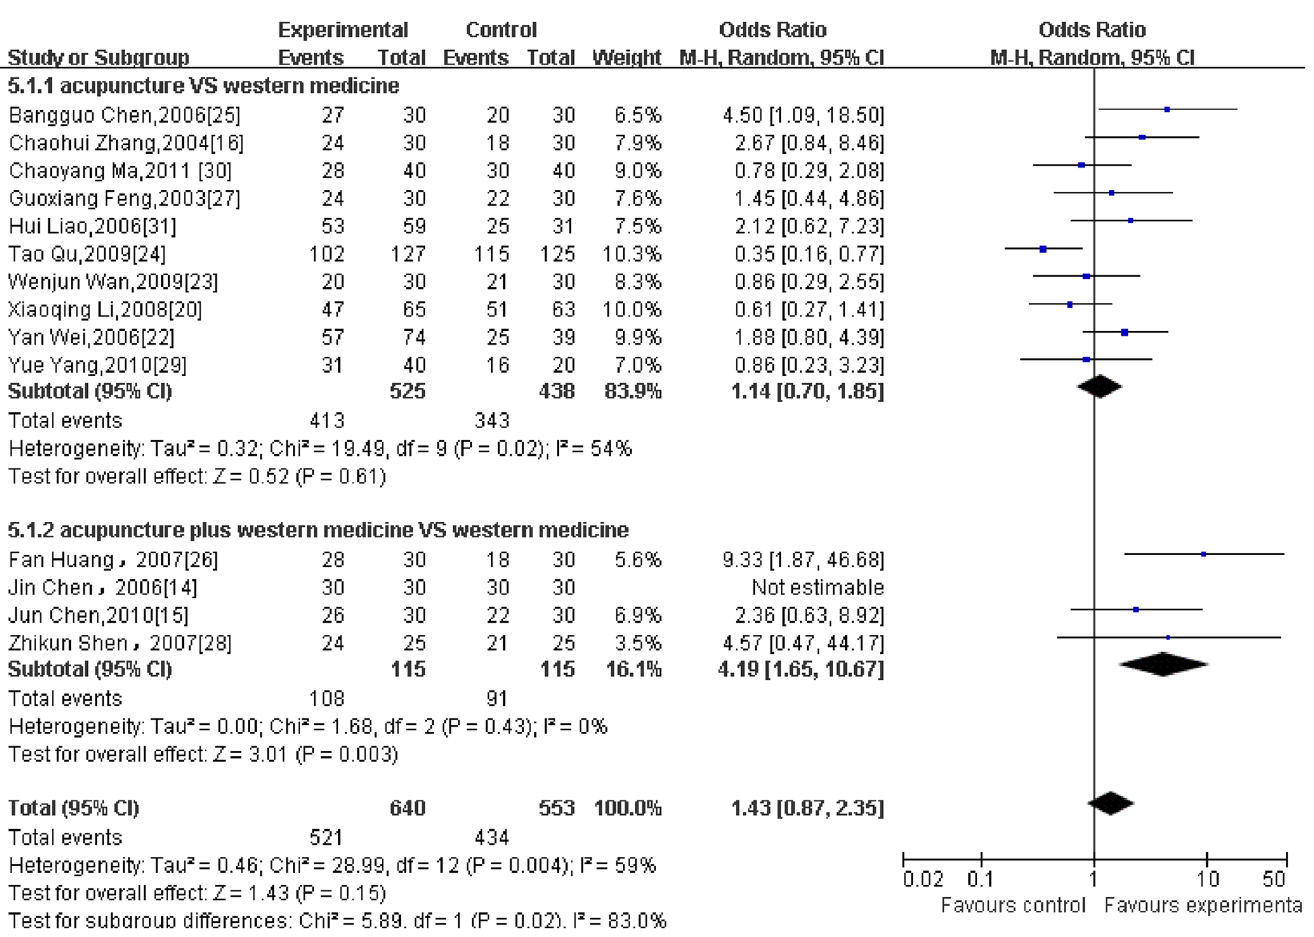
and inter-quatile ranges,2 of them were pooled in the subgroup of acupuncture versus sham acupuncture. And it turned out that there were no significant differences between acupuncture and sham acupuncture (Fig 4: 2 trials with 216 patients, SBP: 0.30, -0.27 to 0.88, I 2 = 0%) while acupuncture arms achieved more significant effect modification on DBP change magnitude than sham acupuncture, with low heterogeneity (Fig 5: 2 trials with 216 patients, DBP: -1.40, -2.37 to -0.44, I 2 = 8%). The other 2 RCTs compared ‘ acupuncture plus medication ’ with ‘ sham acupuncture plus medication ’ and they were combined in this subgroup. The result yielded a beneficial effect of acupuncture combined with western medicine compared to sham acupunc- ture plus western medicine, with no heterogeneity. (Figs 4 and 5: 2 trials with 170 patients, SBP: -7.47, -10.43 to -4.51, I 2 = 0%; DBP:-4.22, -6.26 to -2.18, I 2 = 0%) 3.5.3 Efficacy rate. 14 RCTs reported efficacy rate as the main outcome and all data were pooled in the forest plot (Fig 6). Of these trials, 4 were pooled as a meta-analysis of acupuncture plus western medicine versus medication alone. And the outcome demonstrated that acupunc- ture as an adjunct to western medicine achieved more favourable effect than medication. (4 tri- als with 230 patients, OR = 4.19, 95%CI: 1.65 to 10.67, I 2 = 0%).The other 10 RCTs were combined in the subgroup analysis of acupuncture versus western medicine. And the result